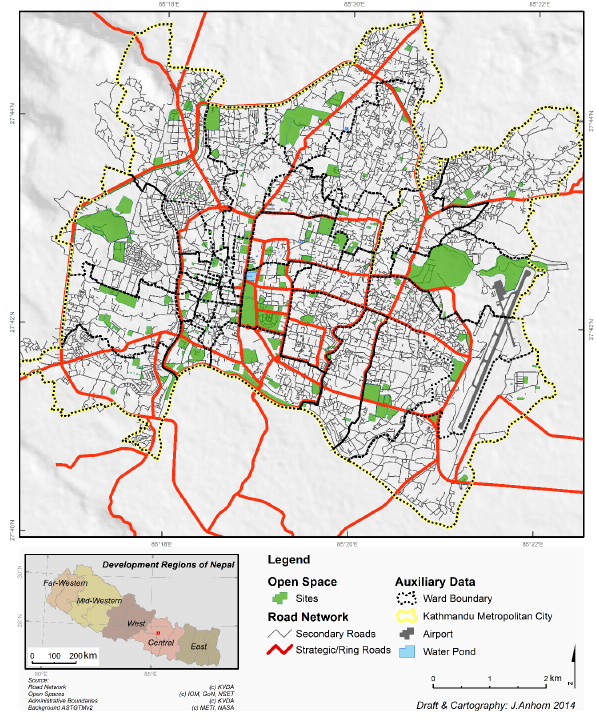
Figure 2. Distribution of open spaces in Kathmandu Metropolitan